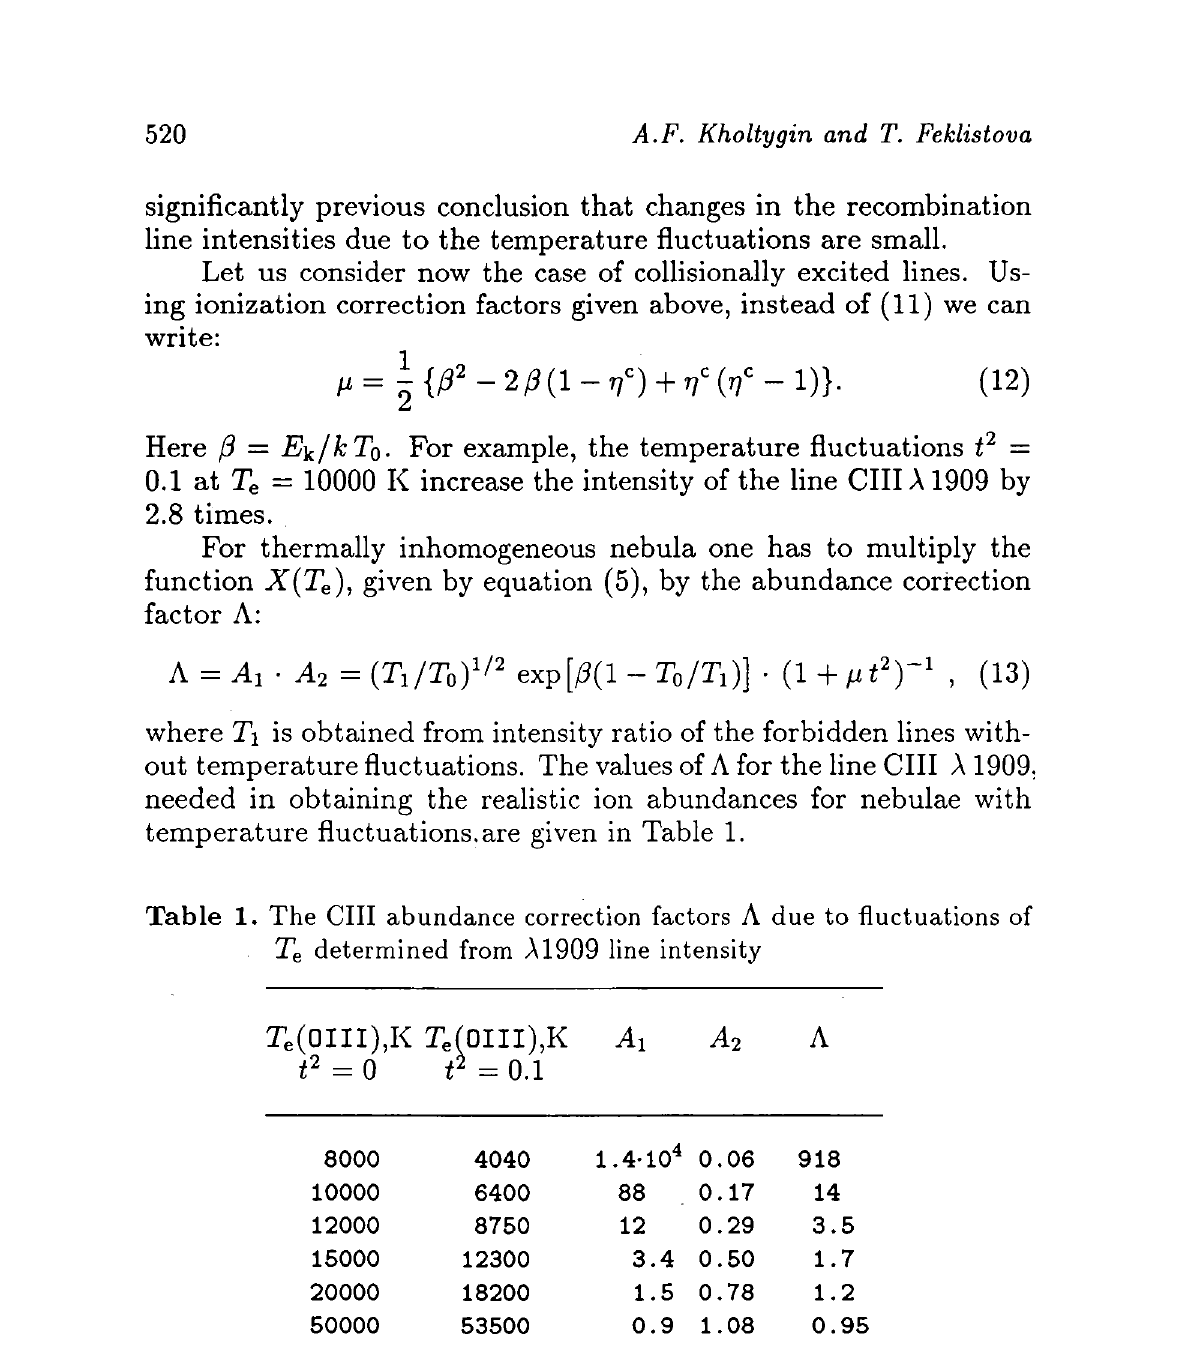
Table 1. The CIII abundance correction factors A due to fluctuations of T e determined from A1909 line